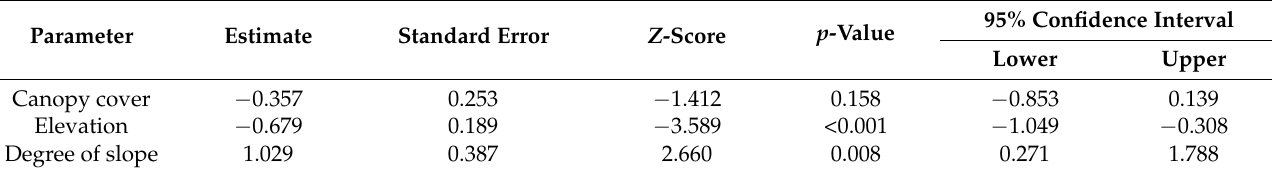
Table 4. Multinomial logistic regression: habitat characteristics of gorilla nest